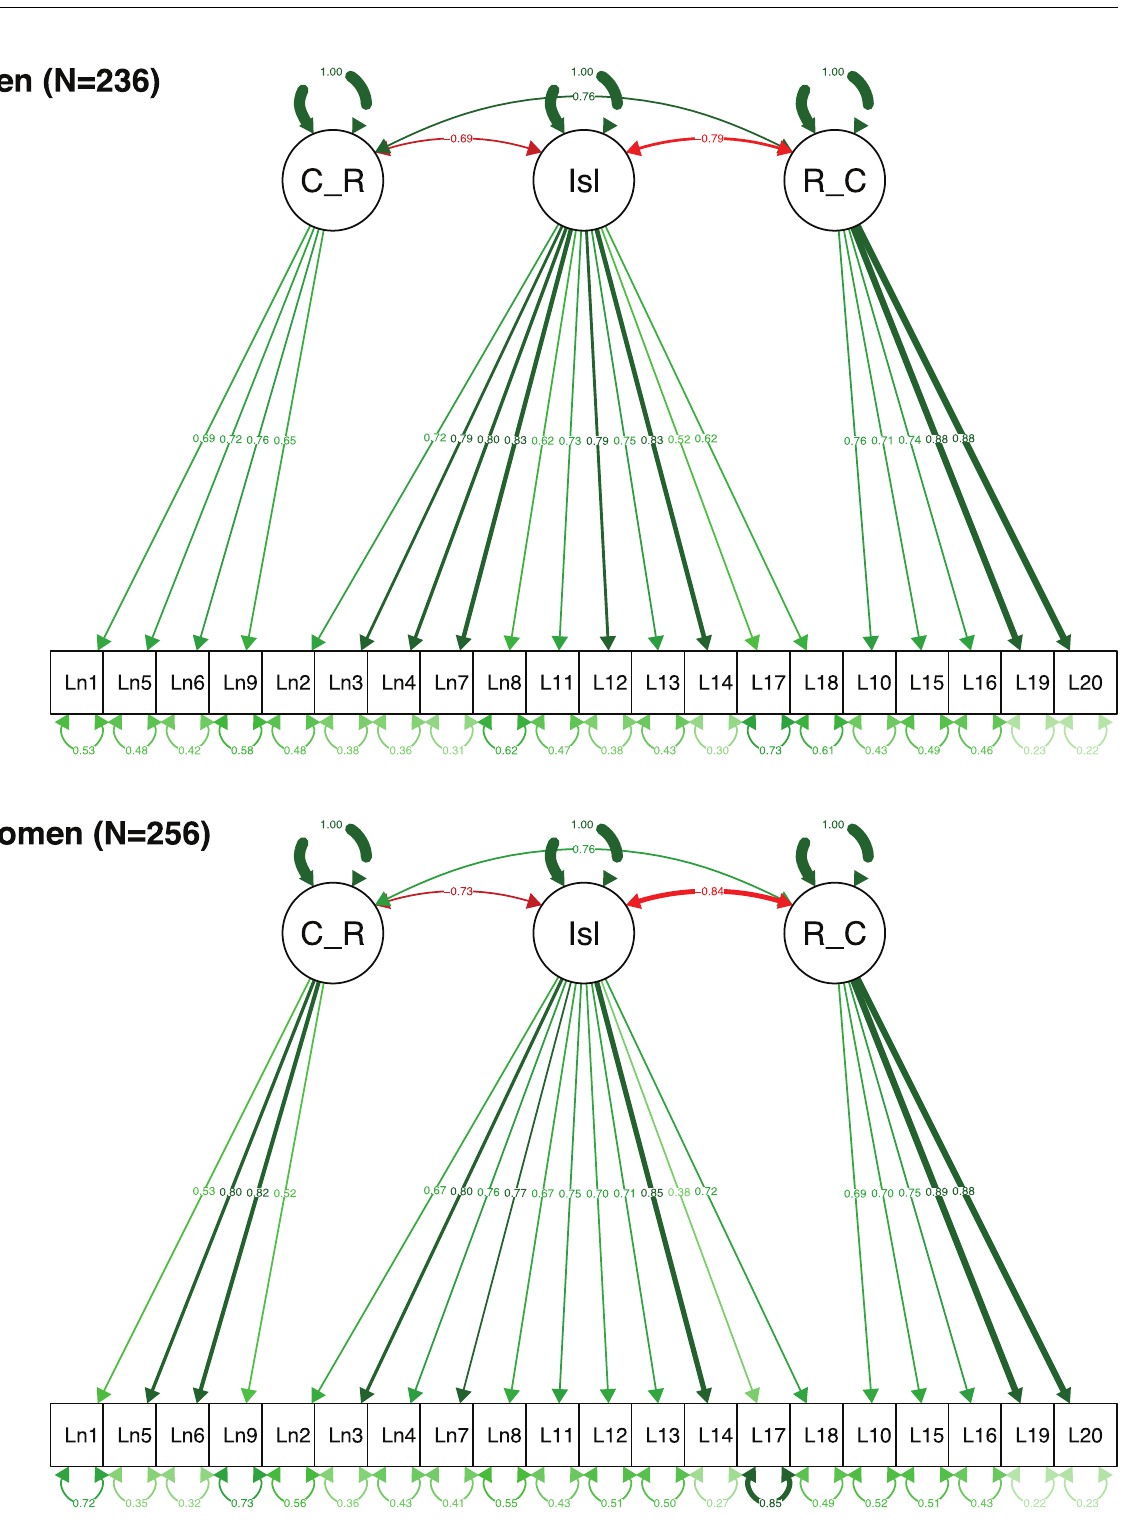
Fig 1. SEM plots for men and women from Sample 1 (nationally representative adults). C_R = Collective Relatedness; Isl = Isolation, R_C = Relational Connectedness. Note: Single headed arrows: factor loadings, double-headed arrows: covariances or error variances associated with